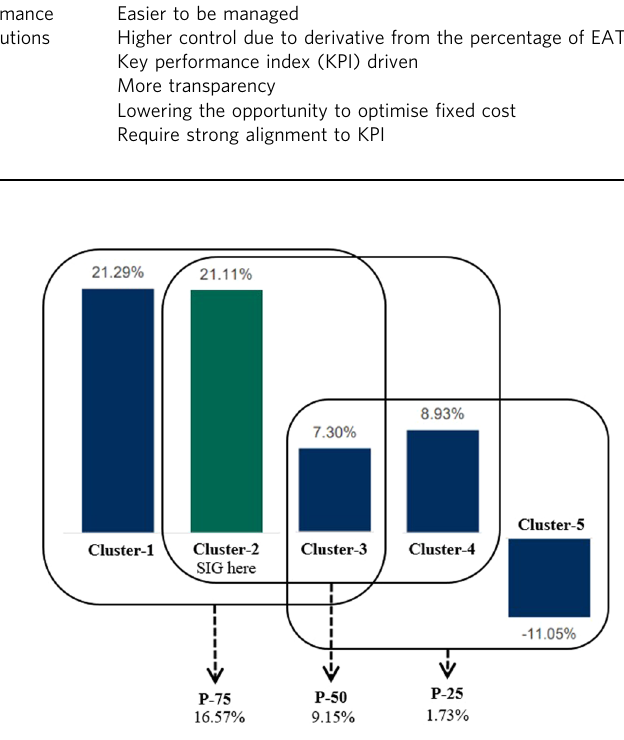
Fig. 7 Determining percentile methods of P-25, P-50, and P-75. To